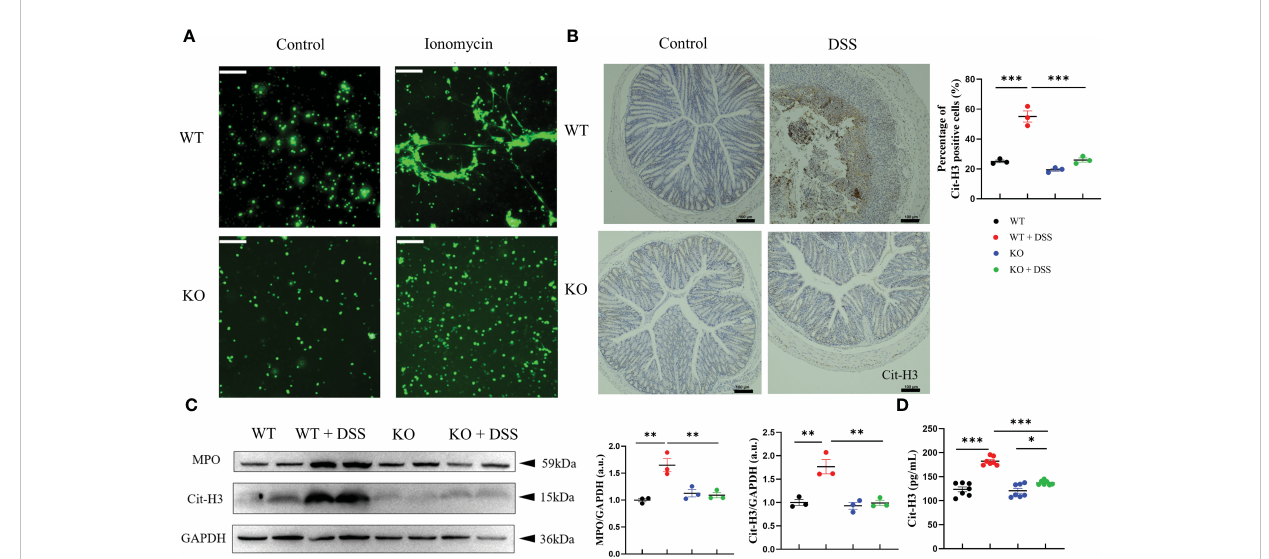
FIGURE 3 PAD4 de fi ciency diminished NETs formation in vivo and in vitro . (A) NETs formation ability in neutrophils isolated from WT mice and KO mice. (B) Representative immunohistochemical images of Cit-H3 positive cells in colon sections (n=3). (C) Western blot analysis of MPO and Cit-H3 in colon tissue (n=3). (D) The concentration of Cit-H3 in serum (n=7). Bars represent 100 m m. * P<0.05 , ** P<0.01 , *** P<0.001 .